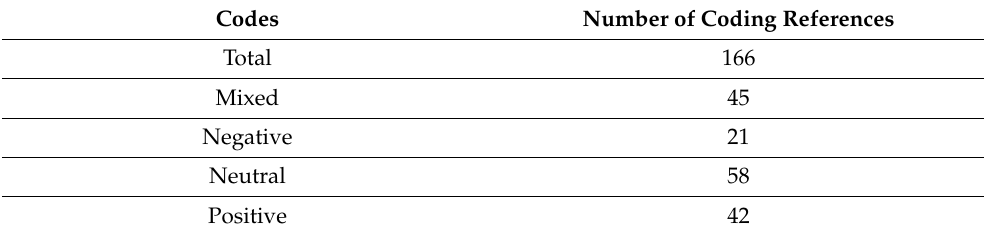
Table 6. Sentiment